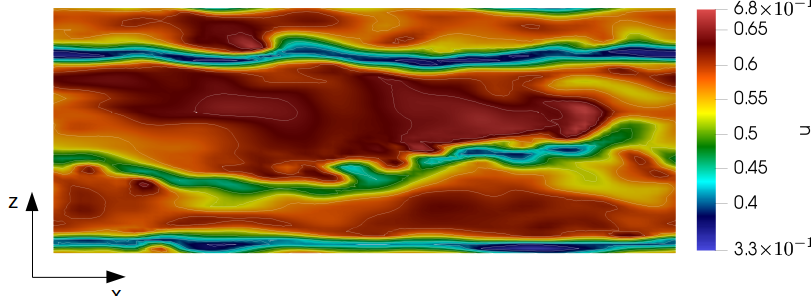
Figure 19. Instantaneous velocity contour in streamwise direction at xz